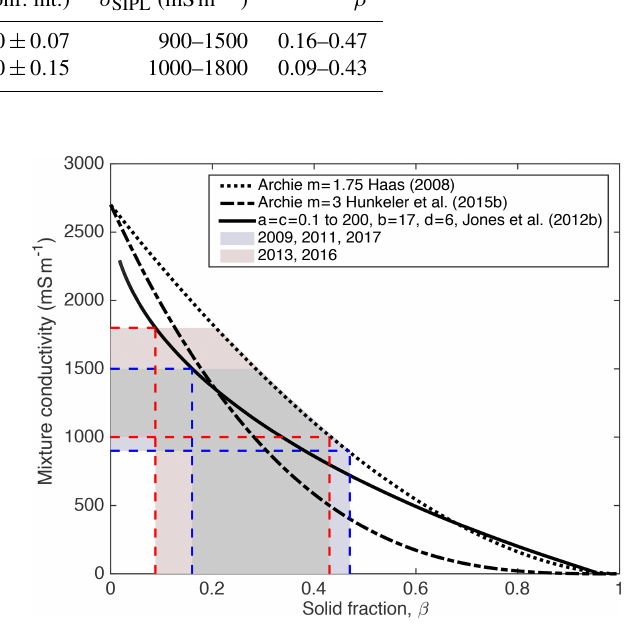
Figure 8. Conductivity vs. solid fraction for porous media accord- ing to theories by Archie (1942) with different cementation factors m = 1 . 75 and 3 and Jones et al. (2012b; black curves). Coloured areas show the range of SIPL conductivities derived from compar- ison of drill-hole and EM SIPL thicknesses (Fig. 5b, Table 1) and resulting solid fractions according to the different